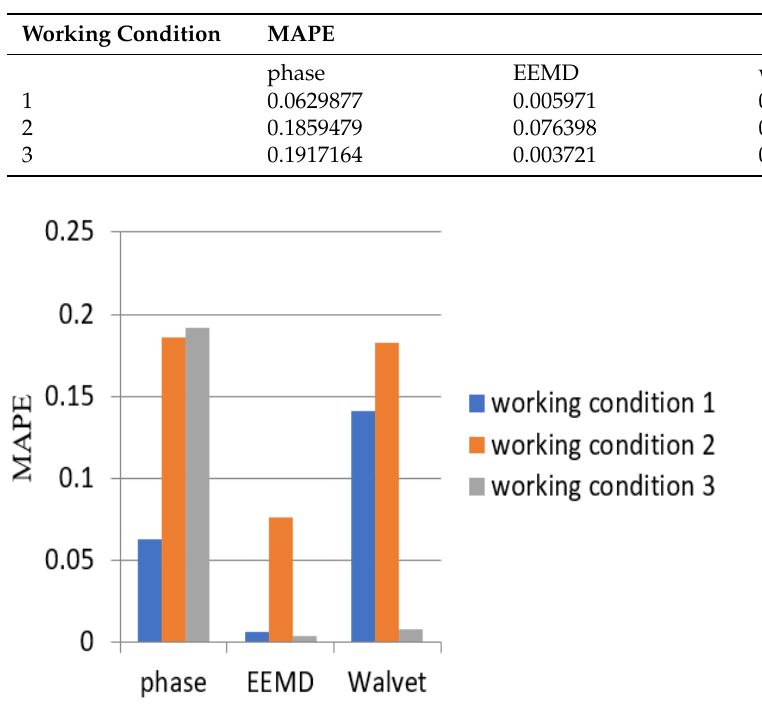
Figure 10. MAPE value in different feature space.